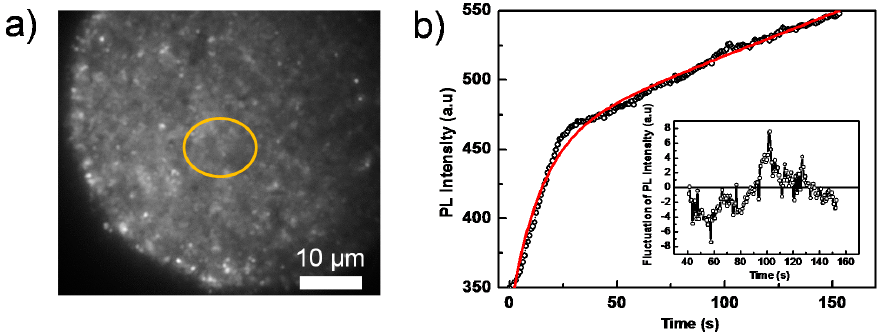
Figure 4. ( a ) Wide-field PL image of a perovskite film, covered with a PCBM quencher layer, taken from a sequence of 200 consecutively-recorded images with an exposure time of 100 ms, an interval time of 500 ms and an excitation intensity of 280 mW/cm 2 ; ( b ) PL intensity trajectory extracted from the yellow circled area in the sequence of images in ( a ). The red line is the fitting line by a bi-exponential function. The inset shows the relative fluctuations of the PL intensity after subtraction of the bi-exponential fit function.